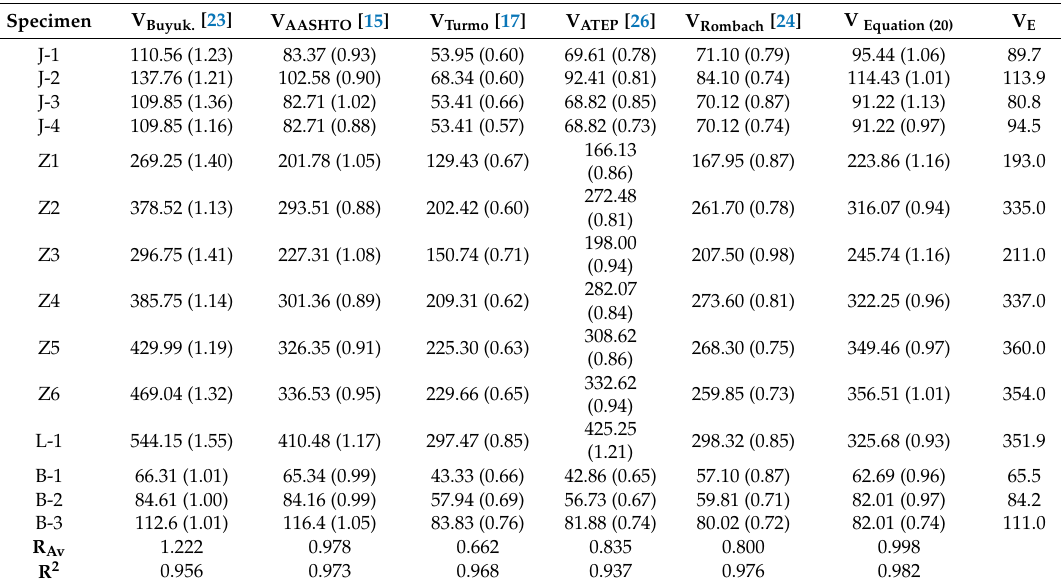
Table 6. Summary of comparative test results (unit: